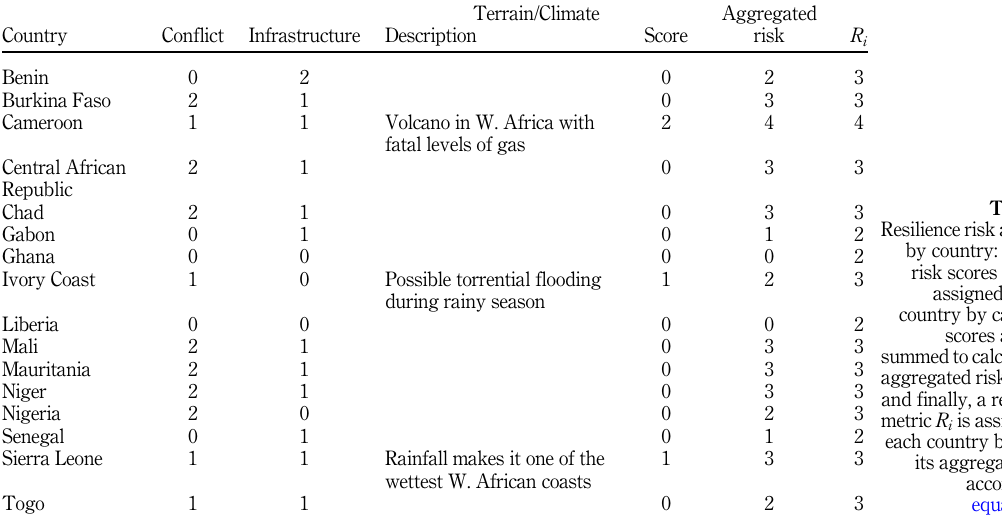
Table 3. Resilience risk